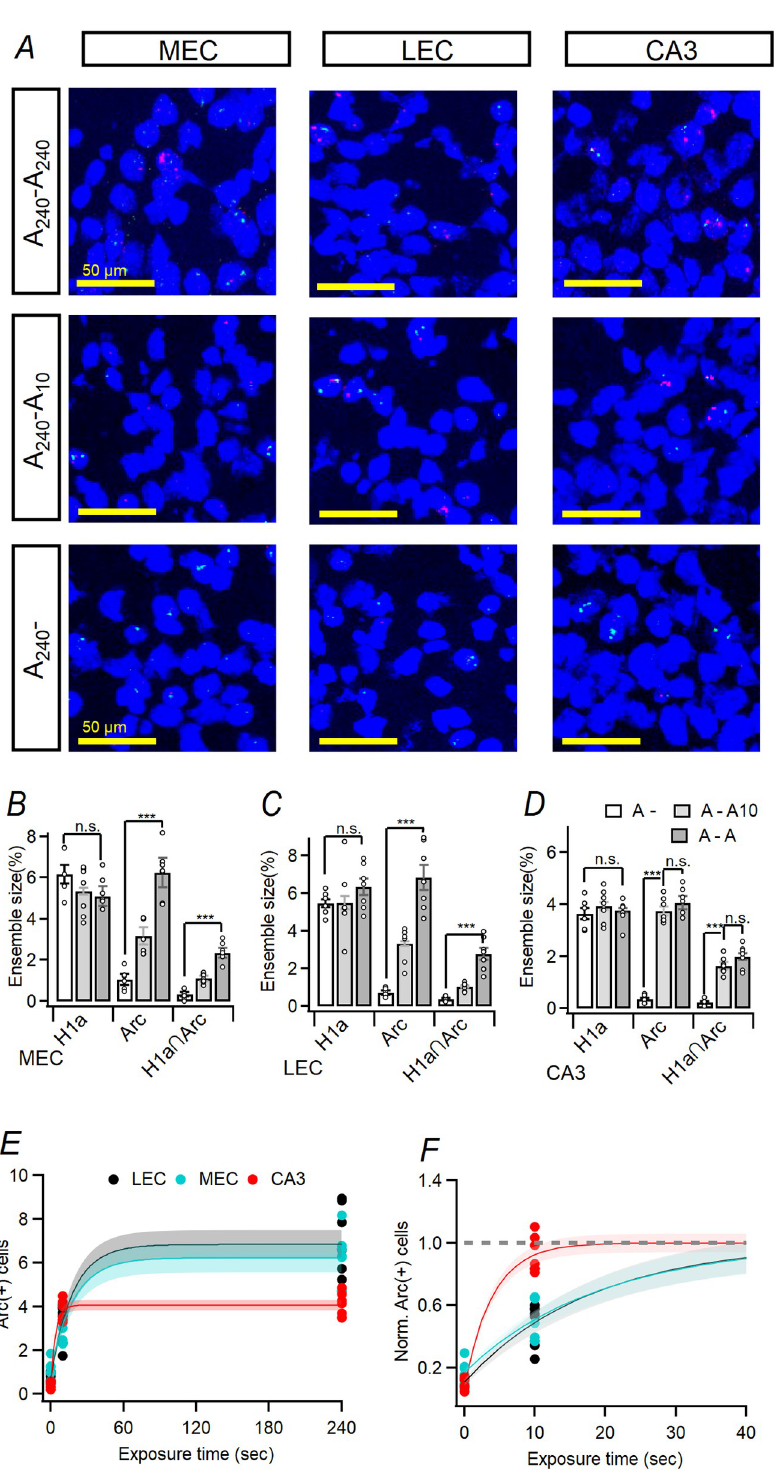
Fig 3. Analysis of ensembles for hippocampal CA3 and LEC/MEC regions. (A) Representative confocal images of H1a (green) and Arc (red) transcripts in nuclei for Layer II of MEC/LEC ( left column and middle column, respectively) and CA3 (right column) from animals of cohort A 240 - (upper row), A 240 -A 10 (middle row) and A 240 -A 240 (right row). (B-D) Summary of the H1a (+) and Arc (+) ensemble size on layer II of MEC (probe: F (1,34) = 47.847, p < 0.001, cohort: F (2,34) = 17.047, p < 0.001, probe × cohort: F (2,34) = 32.721, p < 0.001; GLM; Fig 3B), LEC (probe: